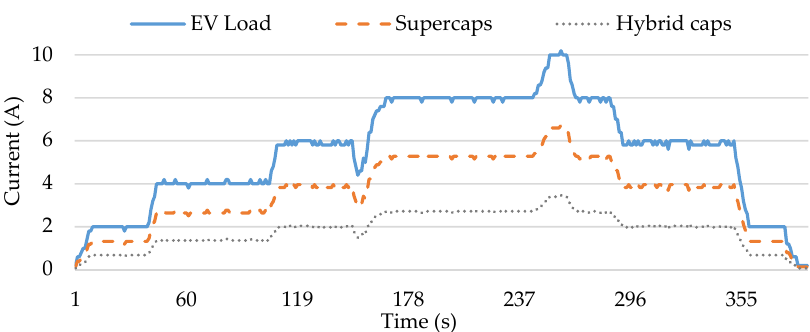
Figure 10. Performance of the experimental SC and HC when directly connected in parallel to a realistic electronic EV load profile.